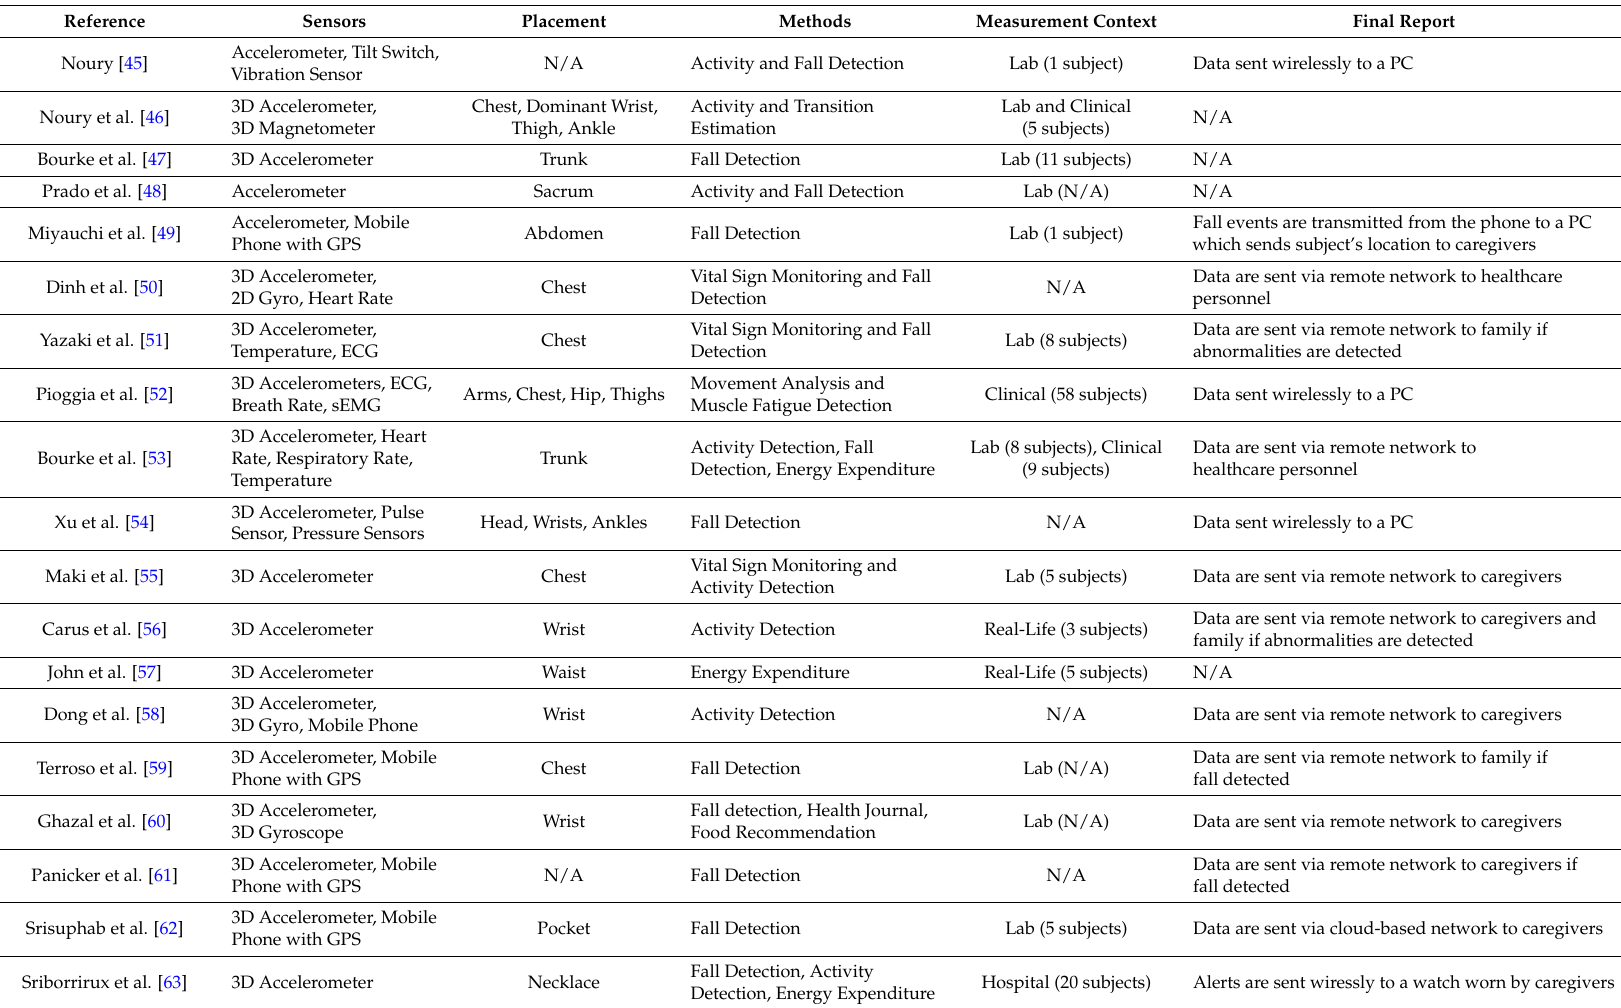
Table 1. Remote Monitoring Systems for Senior